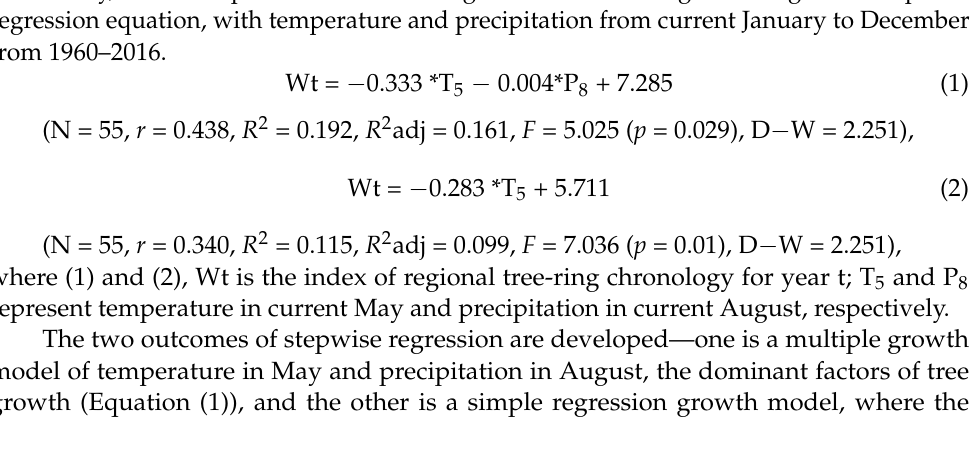
Figure 6. Correlations between PC1 and regional scPDSI (J – J: prior July to current June).